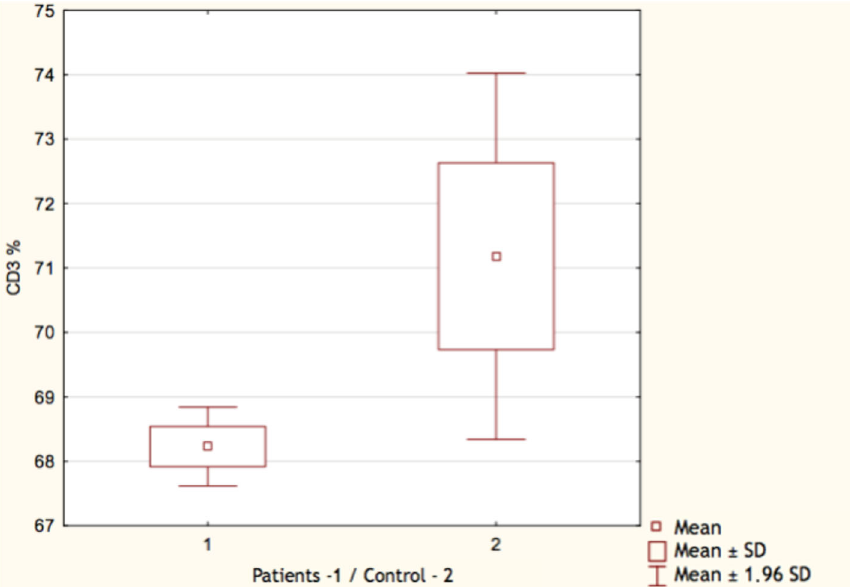
Figure 3. Percentage of CD3+ lymphocytes in patients (1) and control group (2).